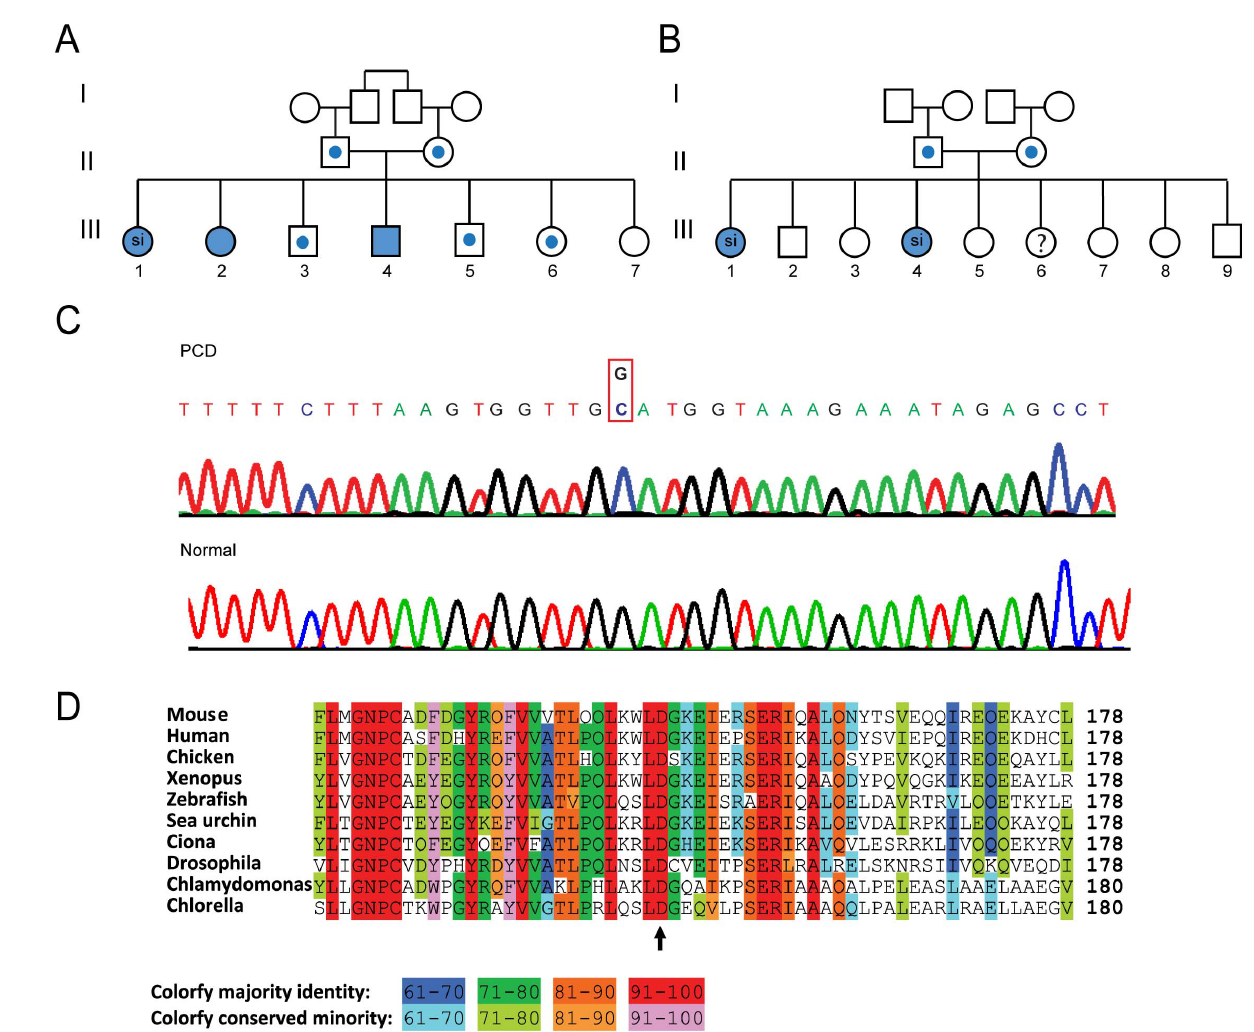
Figure 1. Family pedigree and genetic analyses. Pedigree of consanguineous kindred from two unrelated families in Palestinian communities ( A and B ). Solid symbols: affected individuals; central dots represent heterozygous individuals; Abbreviations: si , situs inversus totalis. Chromatogram showing the nucleotide sequence ( C ) of the LRRC6 Exon 5 adjacent to the mutation site, which resulted in G-to-C change at base position, c.436 (Chr8:133645203). Amino acid sequence of the LRRC6 protein around the mutated residue. Note the high degree of conservation in diverse organisms that have motile cilia or flagella ( D ).